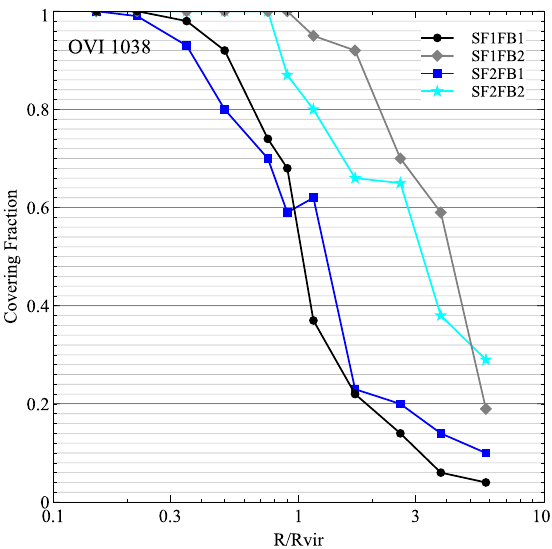
Figure 10. CGM OVI covering fractions in a sub-L ∗ simulated galaxy at z = 3 for different subgrid models. SF#FB# corresponds to whether the simulations uses star formation model 1 or 2 ( SF1 and SF2 ), and stellar feedback model 1 or 2 ( FB1 and FB2 ). SF1 uses a density threshold for